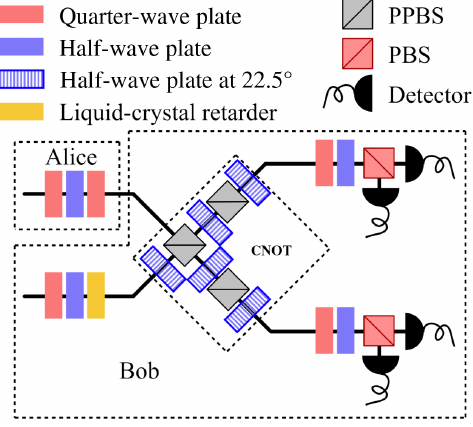
FIG. 16. Experimental setup for our secure comparator two- party protocol.